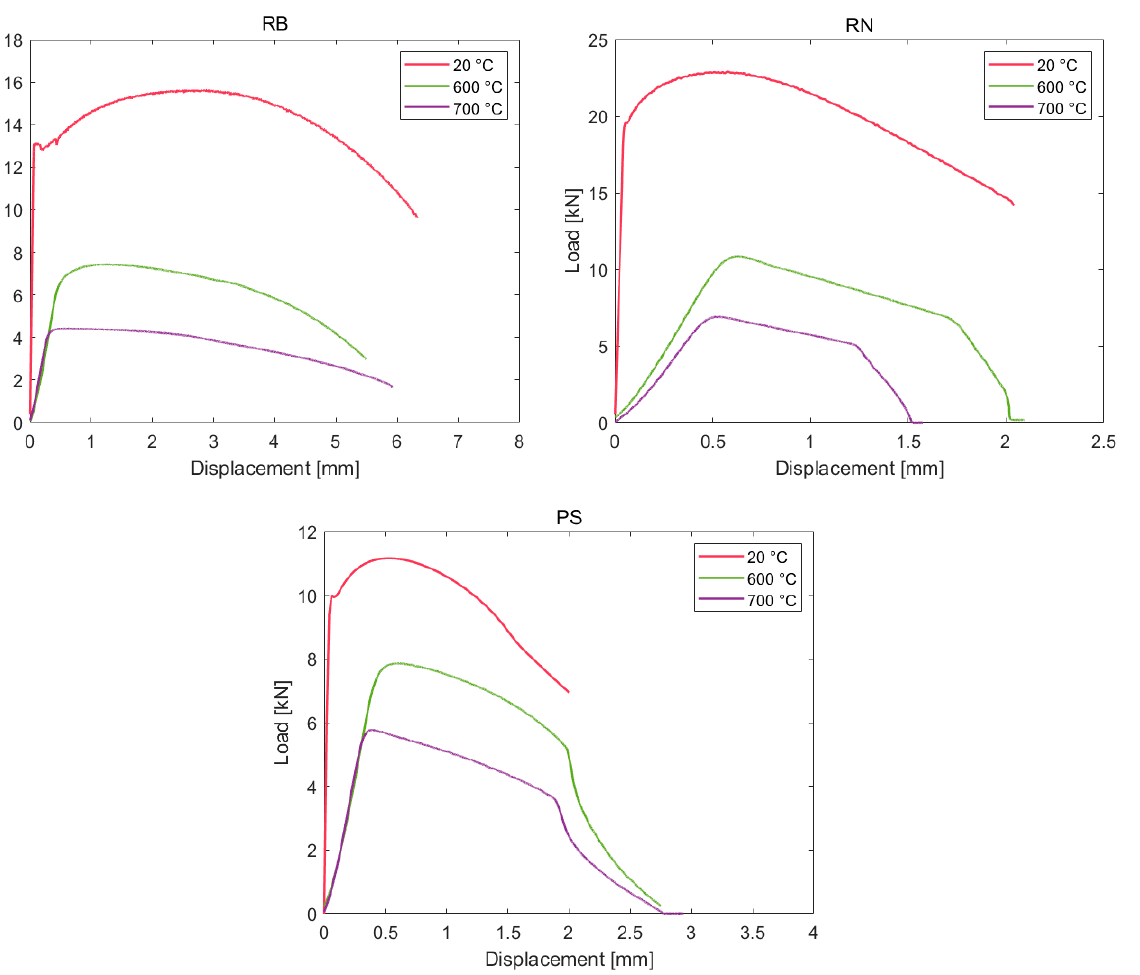
Figure 14. Load–displacement curves of RB, RN and PS tests at different temperatures.